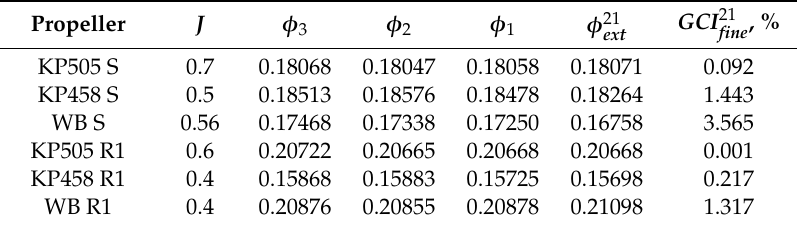
Table 5. The verification study for K TO .